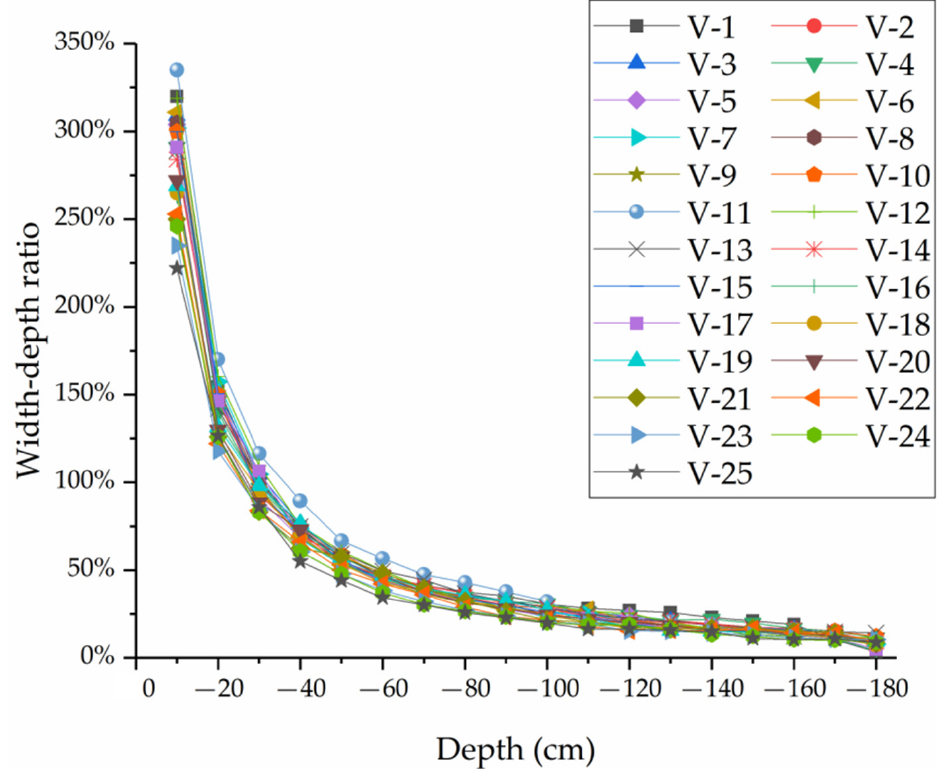
Figure 14. The relationship between width–depth ratio and depth of the ground fissure.